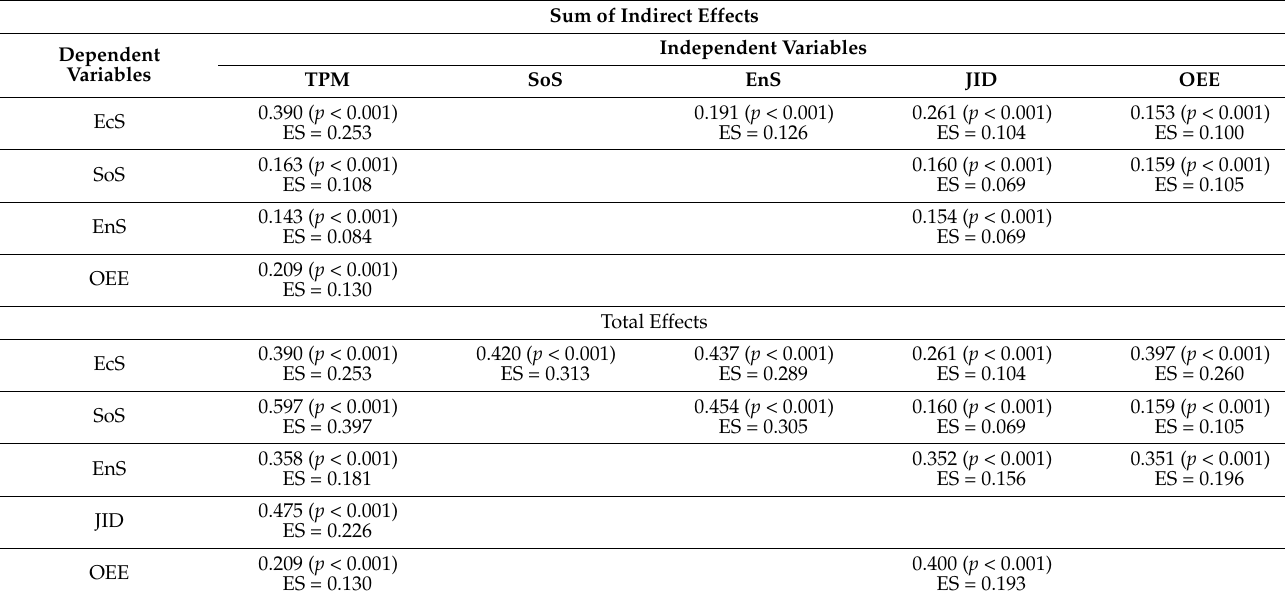
Table 5. Sum of indirect and total effects.